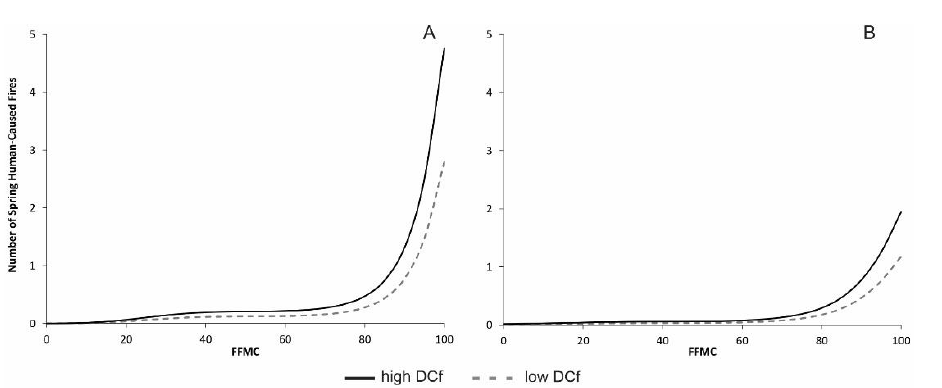
Figure 3. Examples of the resultant zero-inflated Poisson models for the daily number of human- caused spring fires and FFMC (Fine Fuel Moisture Content) under low and high DC f values for ( A ) Grande Prairie and ( B ) Kirkland Lake. Values for low and high DC f are the same as those shown in Figure 2.